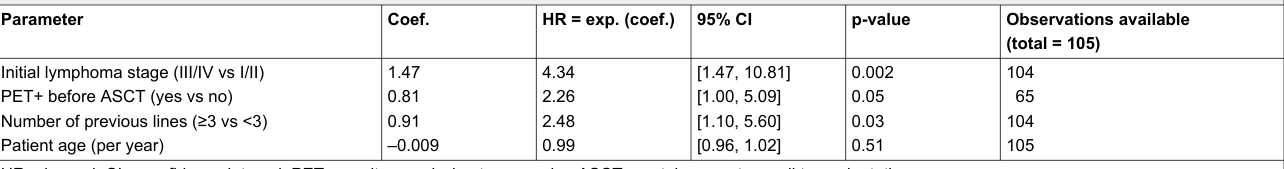
Table 5: Multivariate Cox regression model for event free survival, including statistically significant parameters from the univariate analysis. Parameter Coef. HR = exp. (coef.) 95% CI p-value Observations available